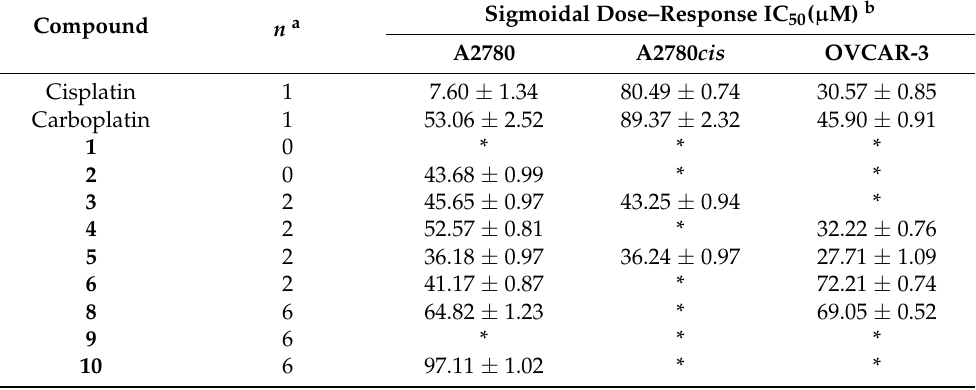
Table 1. The cell growth inhibitory capacity of formamidinate ligands ( 1 , 2 ), dirhodium(II,II) com- plexes ( 3 – 10 ), as well as the carboplatin and cisplatin in cancer cell lines (A2780, A2780 cis , and OVCAR-3) were all expressed as half-inhibitory concentrations IC 50 ( µ